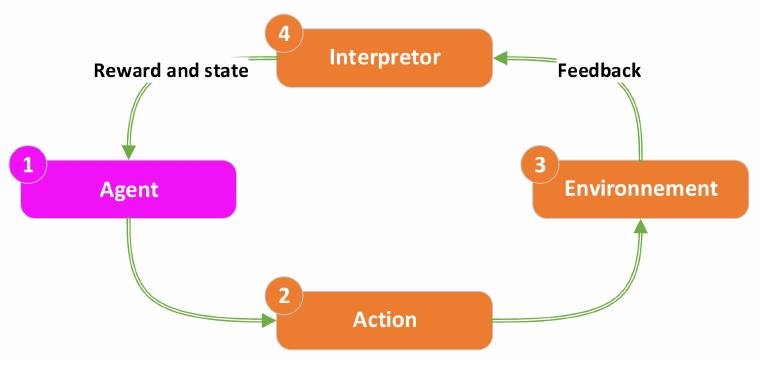
Figure 14. Overview of RL in